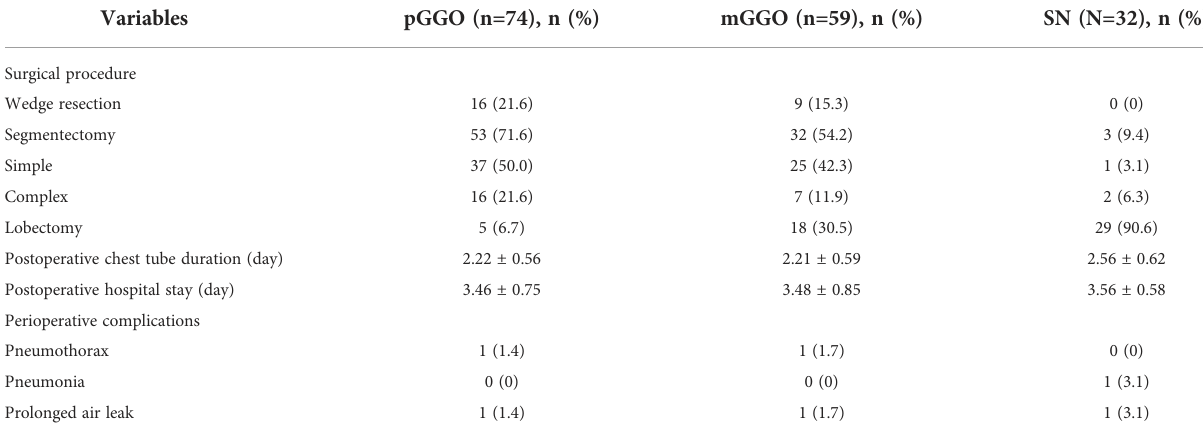
TABLE 4 Perioperative results and